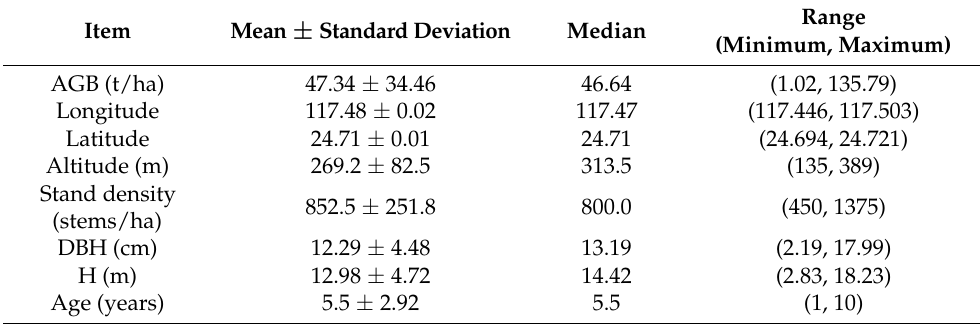
Table 1. Statistics of inventory plots.